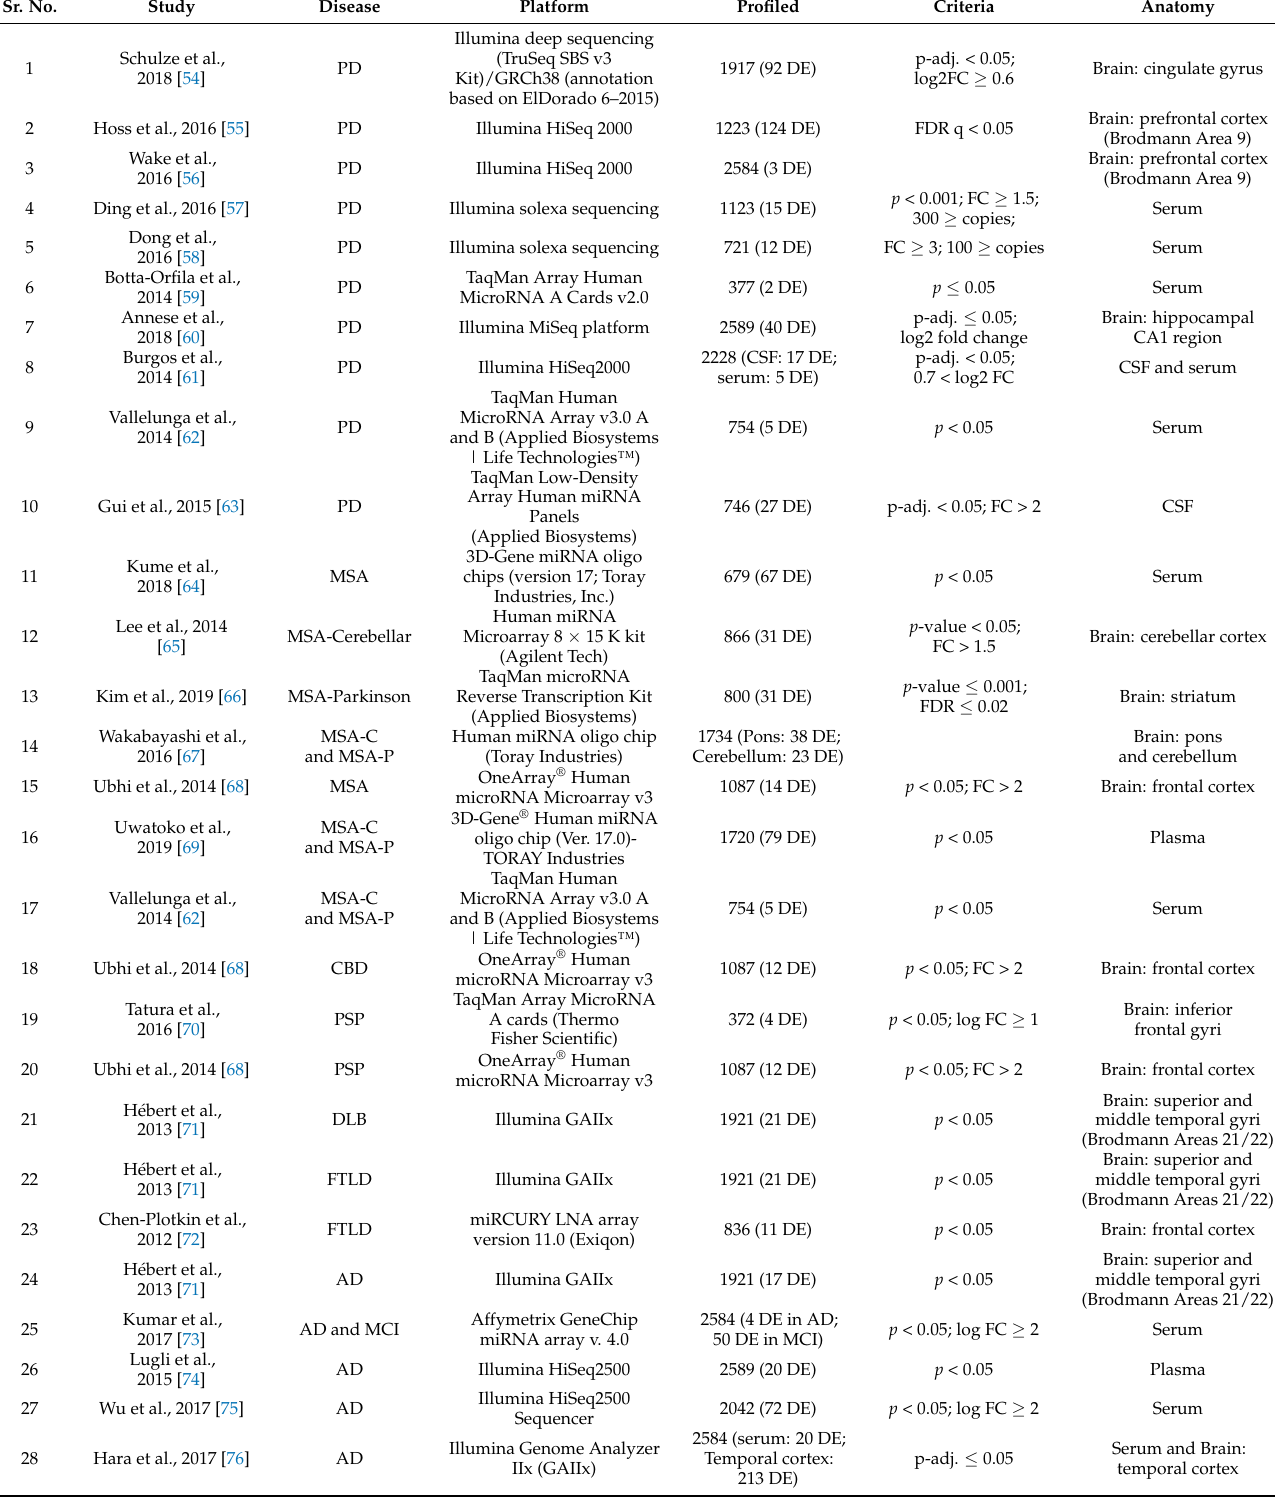
Table 1. List of Neurodegenerative diseases included in the meta-analysis categorized by disease. Sr.